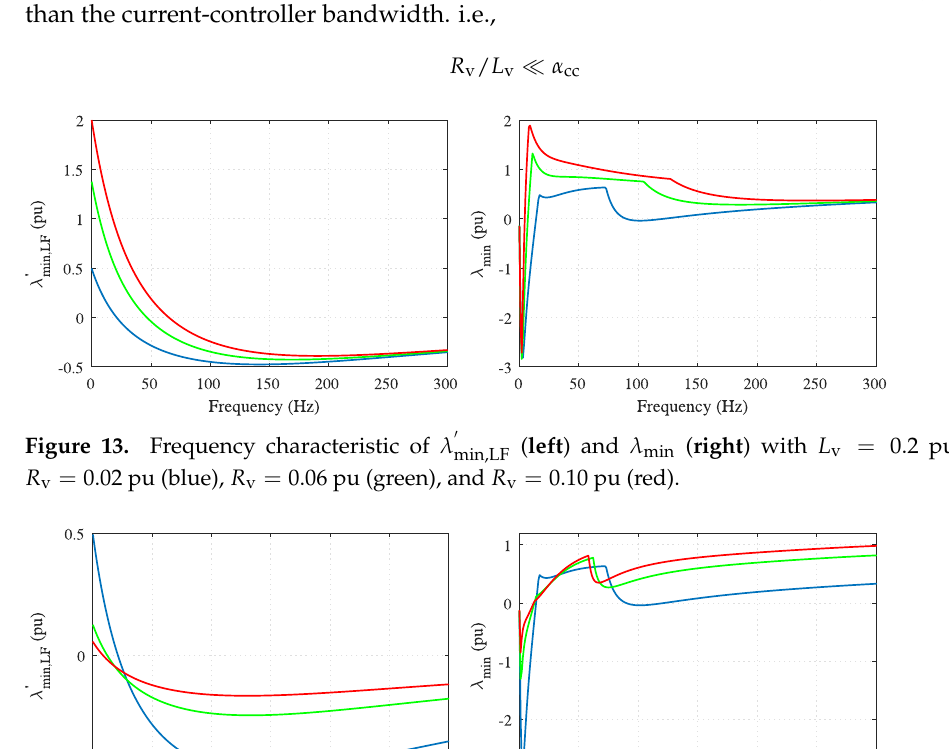
( left ) and λ min ( right ) with R v = 0.02 pu and min,LF